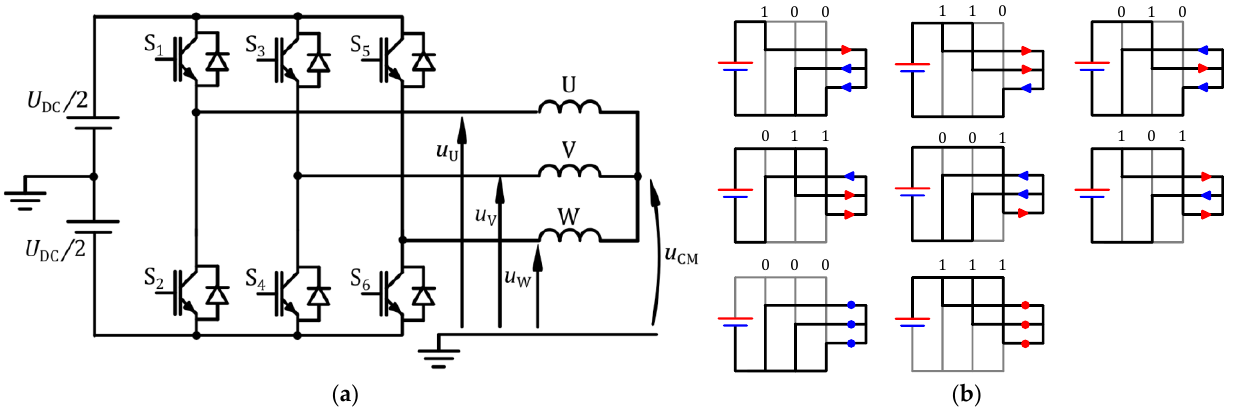
Figure 2. Diagram of a two-level DC-AC converter ( a ) and transistor switching combinations ( b ). The sequence and switching times of the individual transistors are controlled by a vector modulator in the control system. The examples of the output voltages of a two- level converter, u u , u v and u w , are shown in Figure 3. The voltages on the individual phases of the winding assume values that depend on the voltage in the DC-link circuit U DC : U DC /2 or − U DC /2. The result of the voltages at the output of the converter formed in such a way is the presence of a non-zero voltage at the neutral point of the winding called the com- mon-mode voltage u CM , the value of which is equal to the average value of the voltages in the individual phases according to formula (2) [18]: 3 WVU CM (2) Figure 3. Examples of waveforms of phase voltages at the output terminals of a two-level DC/AC converter and the common-mode voltage u CM . The turn-on times of transistors depend on the amplitude of the voltage vector and the sector in which it is located. The construction of the voltage vector V ref can be described by Equation (3) [19]: